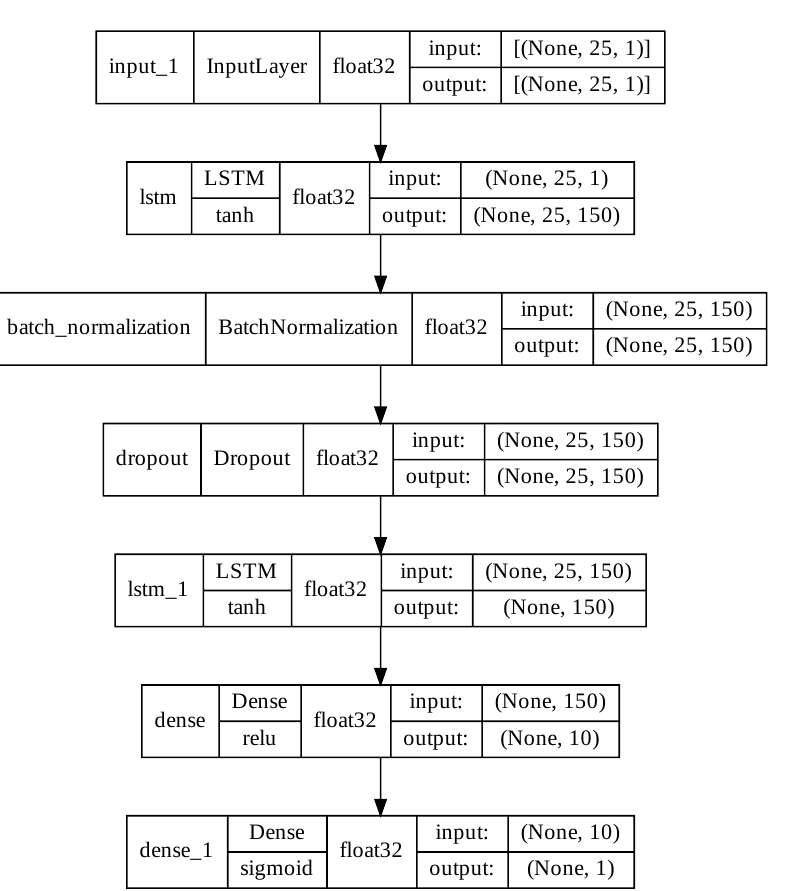
Figure 4. LSTM-based sequence